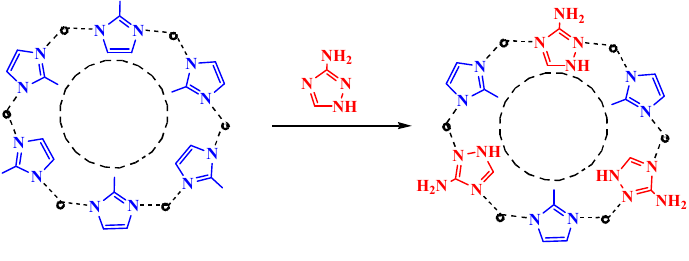
Scheme 8. Structure of Zn,Co ‐ ZIF ‐ Atz. Table 10. Reaction between ECH and CO 2 in the presence of ZIF ‐ 8 and Zn,Co ‐ ZIFs Table 10. Reaction between ECH and CO 2 in the presence of ZIF-8 and Zn/Co-ZIFs. № Catalyst №